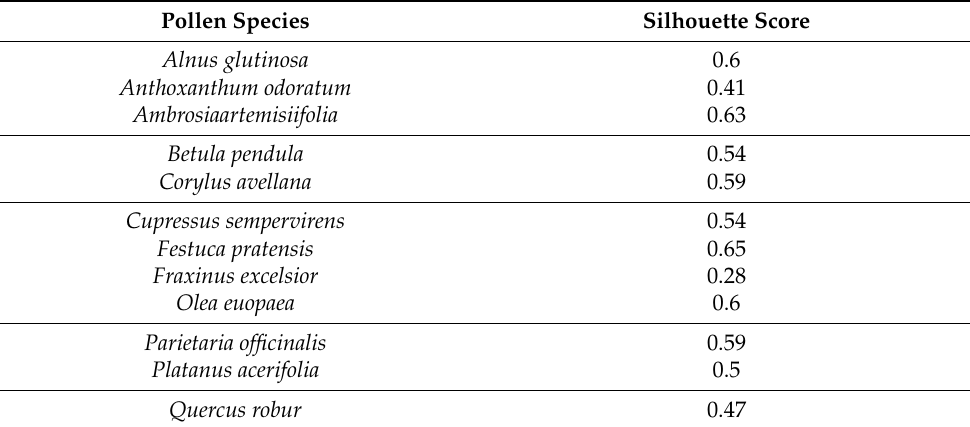
Figure 4. Volume size distributions of Olea measurement session before and after the outlier treatment procedure. Table 2. Average silhouette scores after partitioning the measurements of each pollen sample into inliers and outliers.